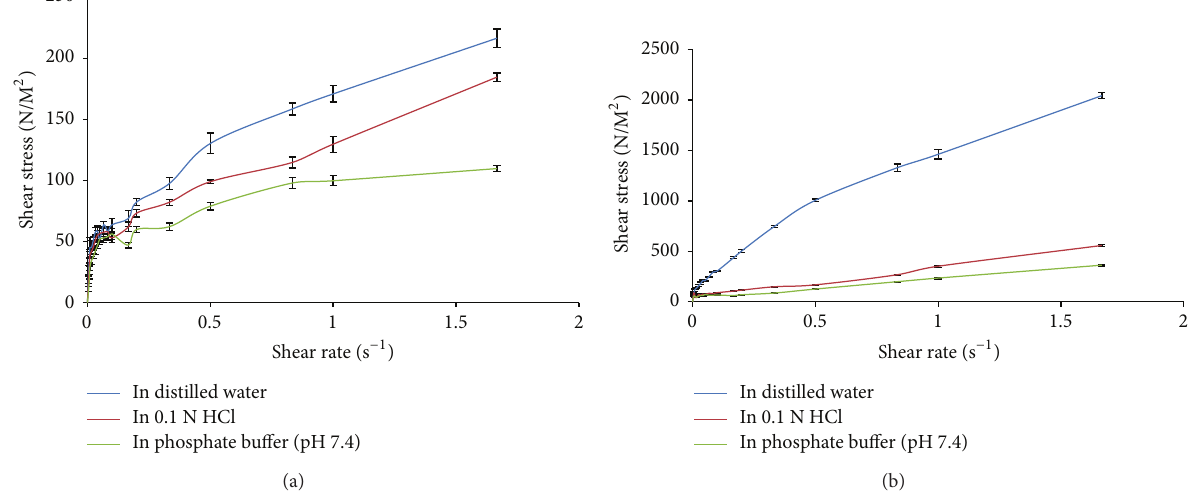
Figure 1: Flow behaviour of 1% w/v gum katira (a) and Isabgol husk (b) in distilled water, 0.1 N HCl, and phosphate buffer (pH 7.4) (the data used in the graph is the mean of three successive results ( 𝑛 = 3 ) and shown with error bars of SD).